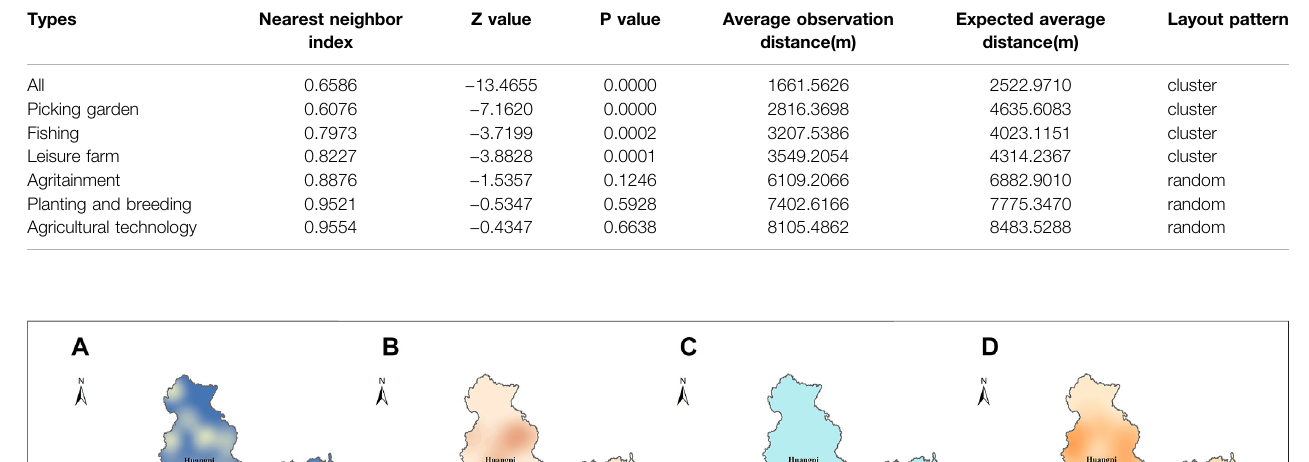
TABLE 3 | Nearest-neighbor index of different types of leisure agriculture in Wuhan.